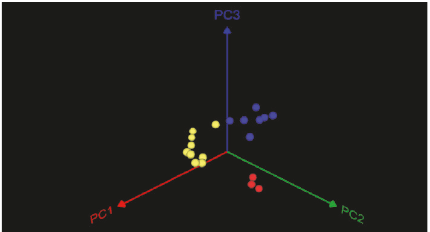
Figure 9: A three-dimensional plot of weighted UniFrac based principal coordinate analysis (PCoA). Colors represented the three groups based on 16S rRNA dendrogram. Yellow, blue, and red balls resembled Groups A, B, and C respectively. Plot was created using the pairwise weighted UniFrac distances (where PC1 is variability at 25.57%, PC2 is variability at 14.69%, and PC3 is variability at 11.44%). Samples from the same group cluster more closely